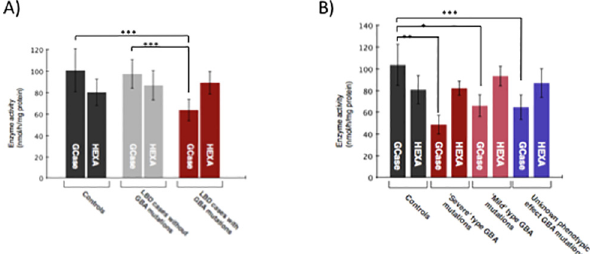
Fig 1. GCase and HexA activity in autopsy brain tissue. A) GCase activity was significantly reduced in LBD cases carrying GBA mutations (n = 16) compared to LBD non- GBA carriers (n = 18) and controls (n = 30). Differences in activity for HEXA were not significant in any group. B) GCase was significantly reduced in LBD cases with mutations classified as ‘ severe ’ type (L444P, 84insGG etc.) compared to controls, and to LBD cases with ‘ mild ’ mutations (N370S) or variants of unknown phenotypic effect (E326K, T369M). Differences in activity for HEXA were not significant. * p < 0.05, ** p < 0.01, *** p <